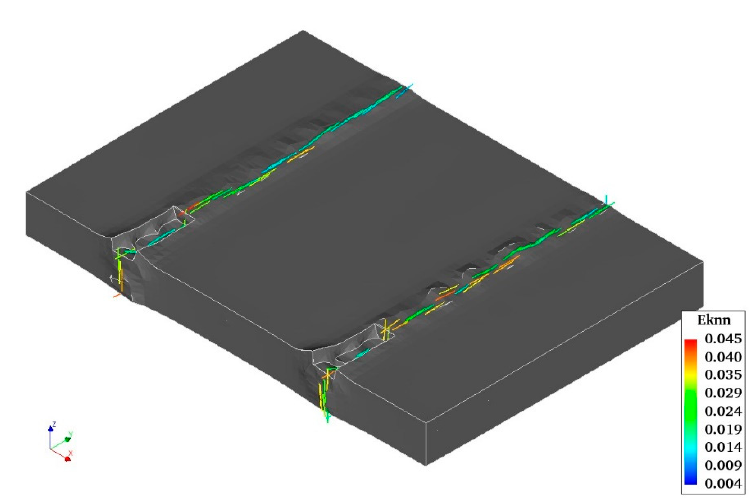
Figure 20. The predicted transverse crack pattern of ARCP-1.